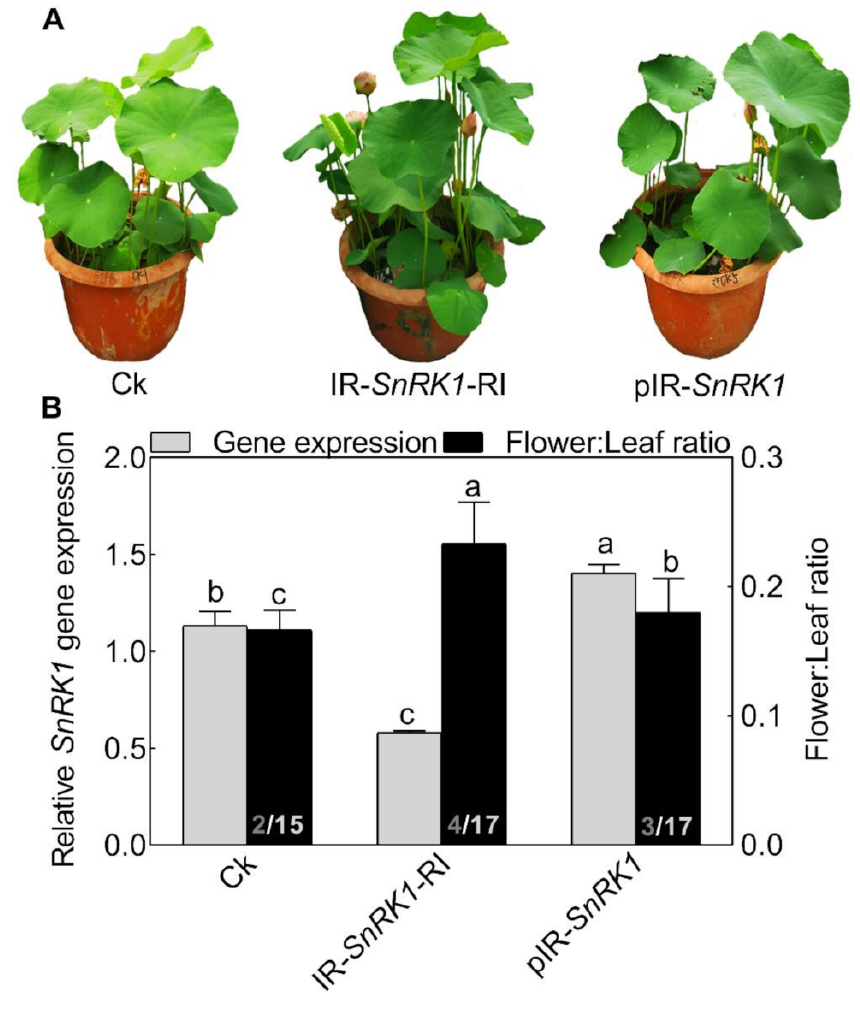
Figure 6. Phenotypes of NnSnRK1 -silenced (IR- NnSnRK1 -RI) and -overexpressed (pIR- NnSnRK1 ) lotus. Two-month-old lotus seedlings were used for infection with IL-60-BS-derived systems. IR- NnSnRK1 -RI, NnSnRK1 -silenced lotus; pIR- NnSnRK1 , NnSnRK1 -overexpressed lotus. The repre- sentative picture was taken after infection for 14 days ( A ), and then the gene expression level of NnSnRK1 genes and the flower:leaf ratio were analyzed ( B ). The numbers on the bottom of each column represent the corresponding number of flowers and leaves of the flower:leaf ratio. Values are the means ± SE of three independent experiments with at least three replicates for each. Bars marked with different letters are significantly different from each other at p < 0.05, according to Tukey’s multiple test.